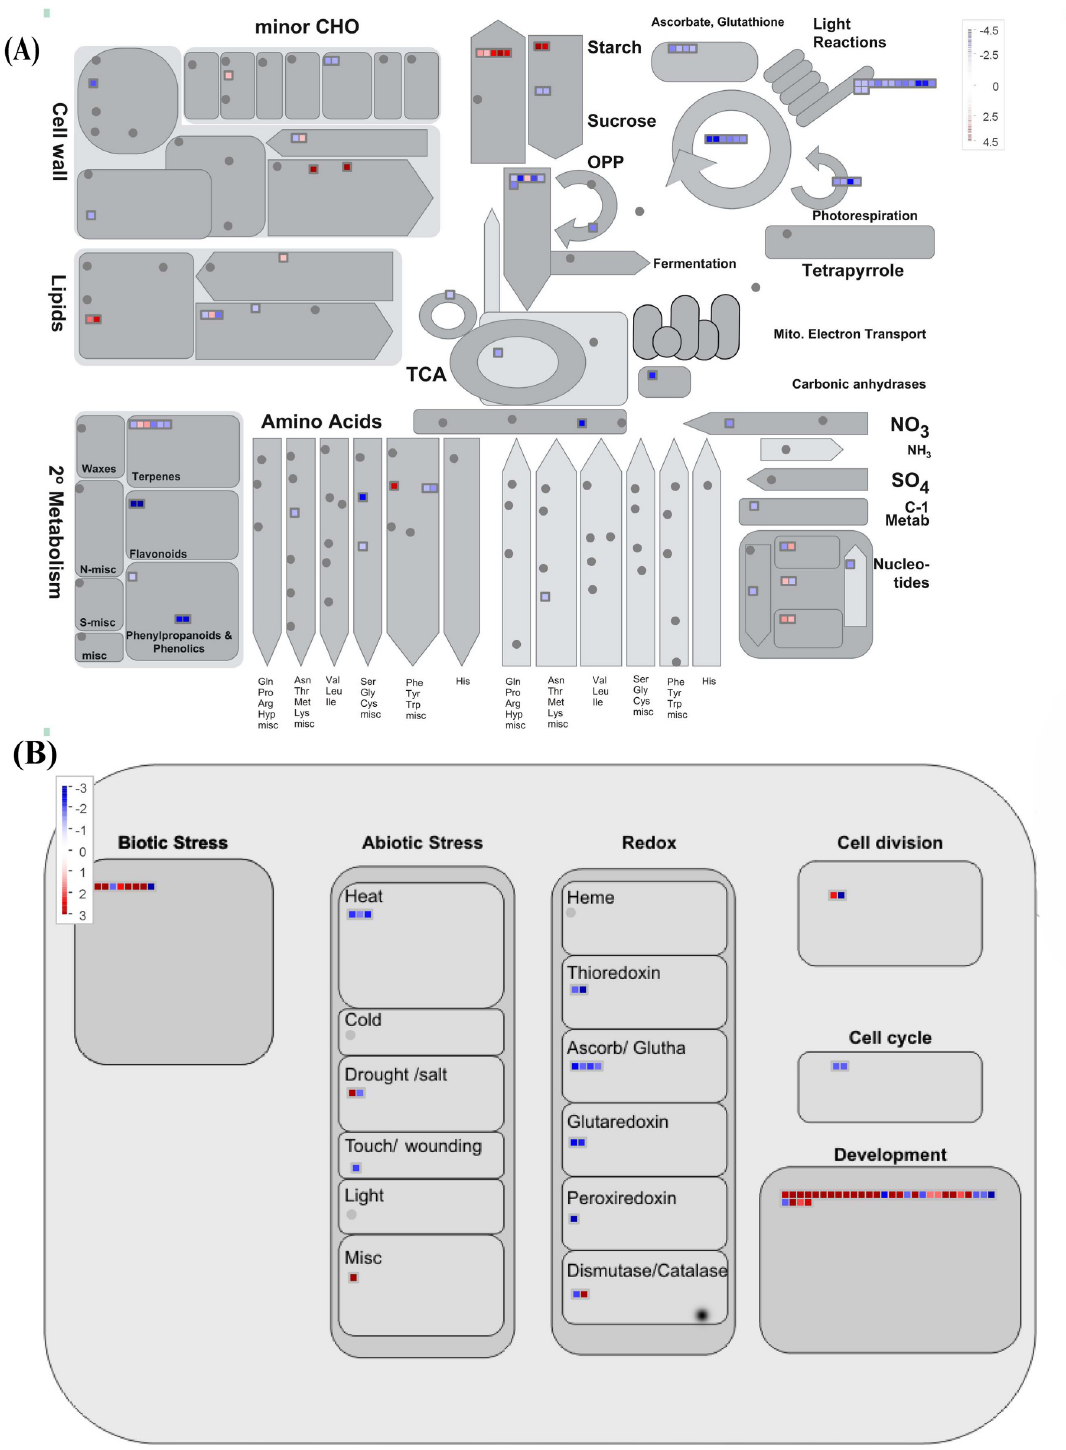
Fig 5. Functional analysis and metabolism overview of specific DEGs in 33S in response to cold stress. A. Overview of metbolism. B. Response activities.